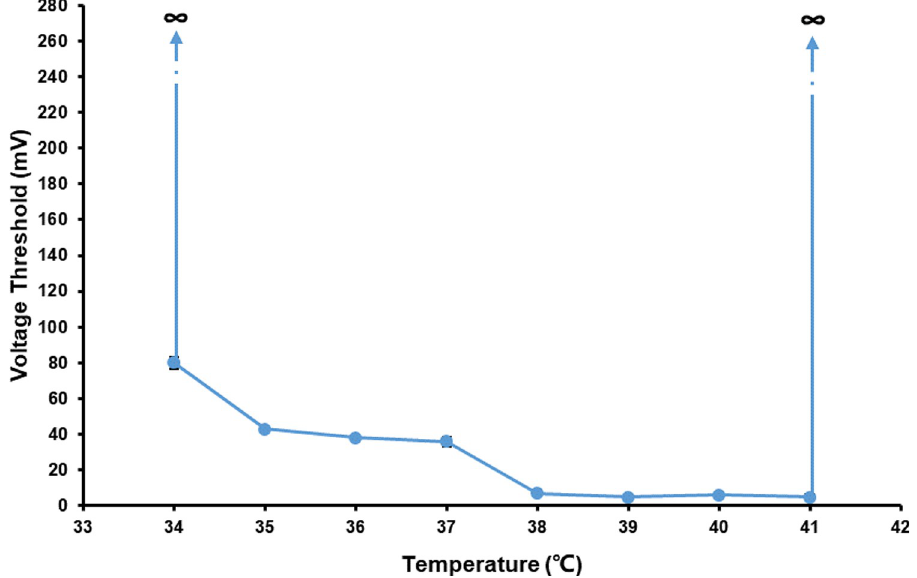
Fig 5. The changes of V Th of PC12 quasi-neuronal networks with temperature ( n =